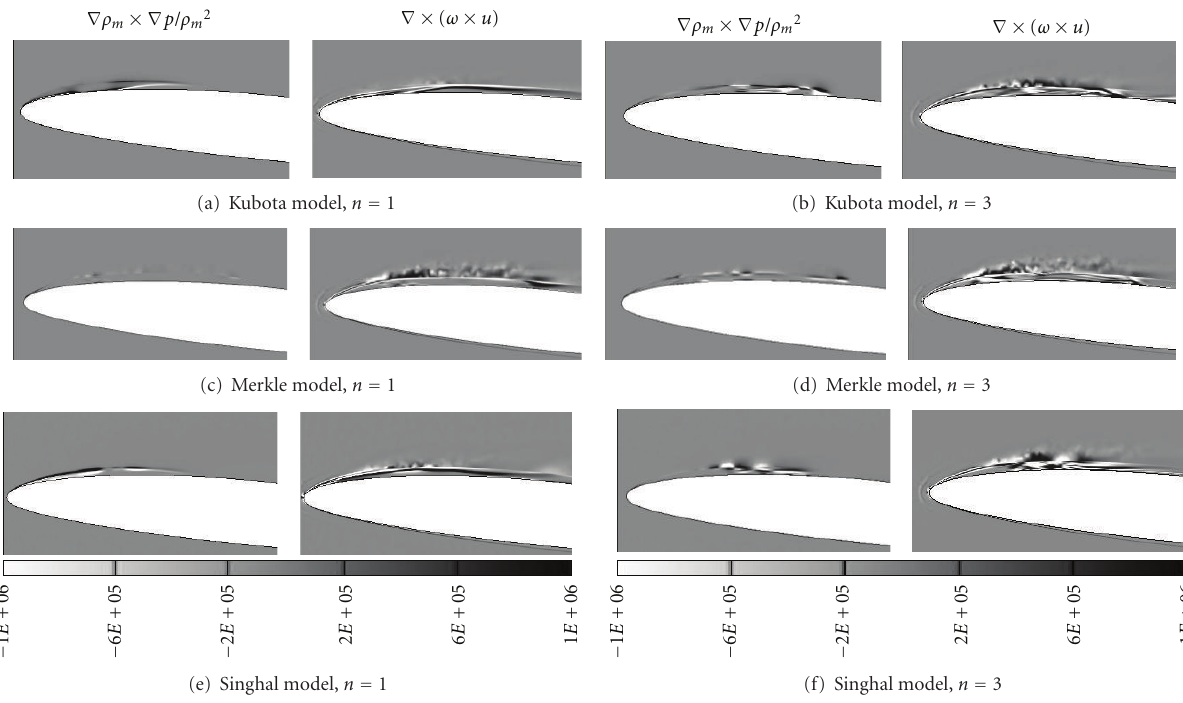
Figure 6: Comparisons of the baroclinic torque and vorticity transport/stretching term in (12) for the di ff erent cavitation models with n = 1 and n = 3 for σ = 1 . 49, Re = 750,000, V ∞ = 5m/s, and α = 6 ◦ .